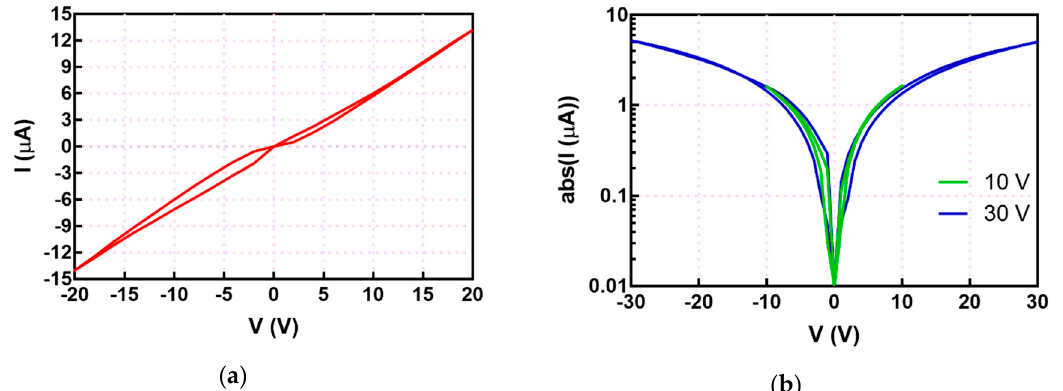
Figure 13. Current–Voltage (I–V) characteristics of fabricated microfluidic memristor, based on liquid TiO 2 inside of the channel, for voltage amplitude, ( a ) 20 V, ( b ) 10 V and 30 V.